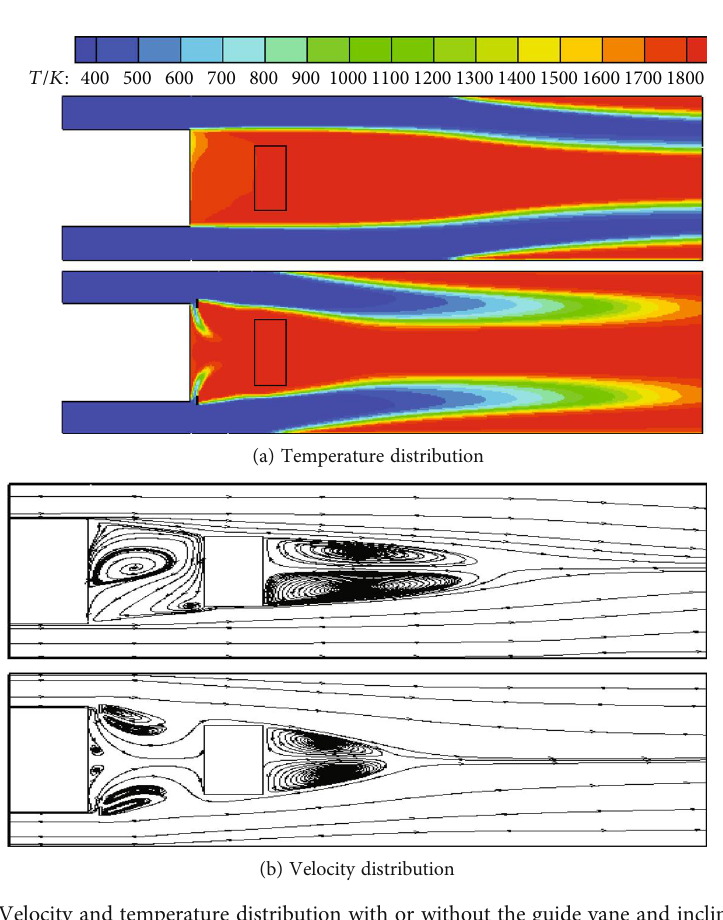
Figure 3: Velocity and temperature distribution with or without the guide vane and inclined